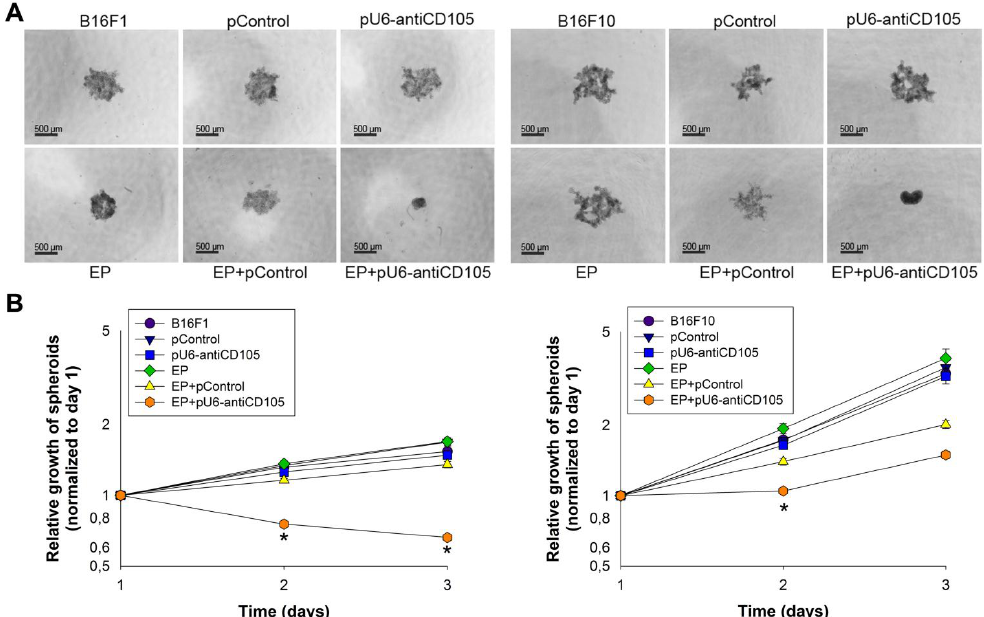
Figure 3. The formation and growth of melanoma spheroids after endoglin silencing. ( A ) The images of B16F1 and B16F10 spheroids 72 h after gene electrotransfer of pU6-antiCD105; ( B ) The growth of B16F1 and B16F10 spheroids after gene electrotransfer of pU6-antiCD105. All data for spheroid growth curves are expressed as arithmetic mean ± standard error of the mean. Asterisks indicate statistically significant differences between EP+pU6-antiCD105 and the control groups (* p < 0.05). The data are from two independent experiments with n =